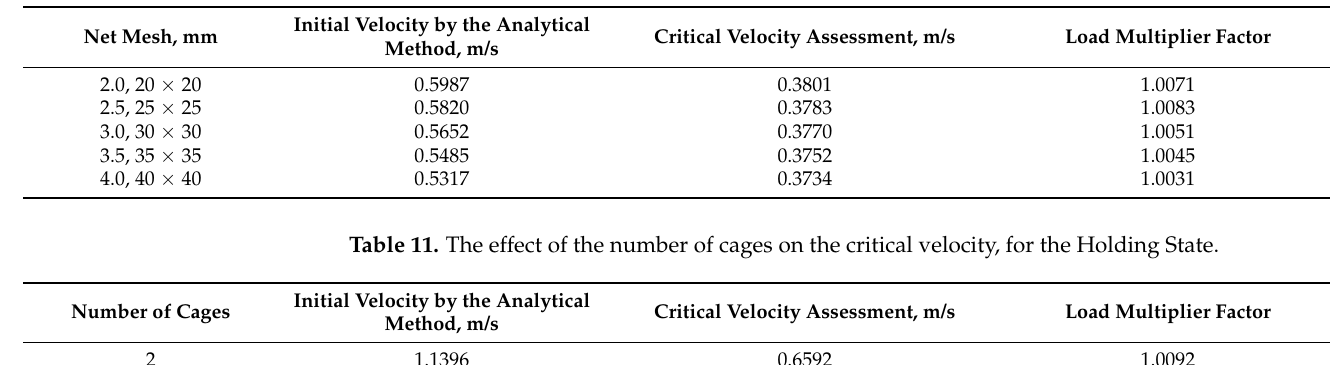
Table 10. The effect of the net mesh and yarn diameter on the critical velocity, for the Holding State.